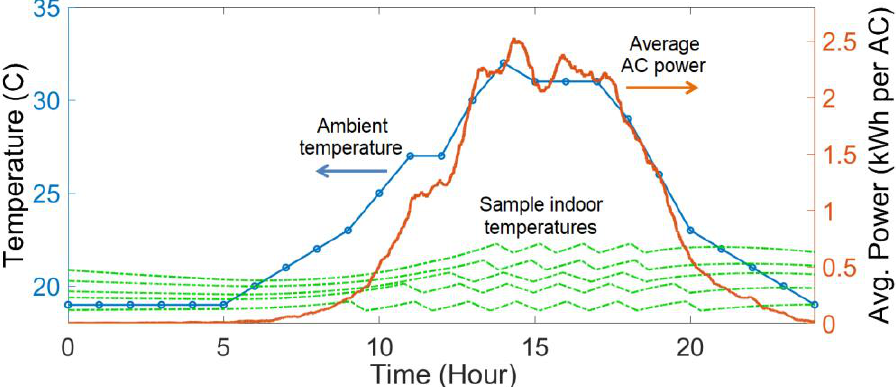
Figure 8. Simulation of 5000 air conditioner (AC) loads: Ambient temperature, aggregate AC power, and 5 sample individual indoor temperatures with different setpoint values near 20 °C.